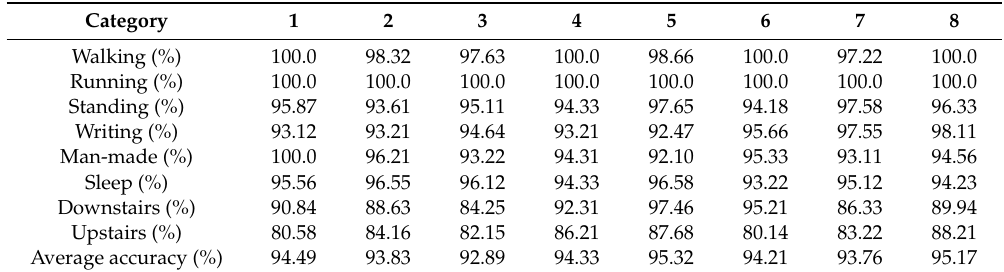
Table 11. Leave-One-Person-Out cross validation (LOPO-CV) experiment accuracy